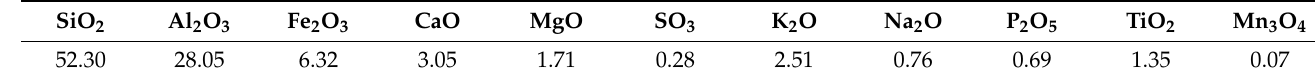
Table 1. XRF FA analysis.